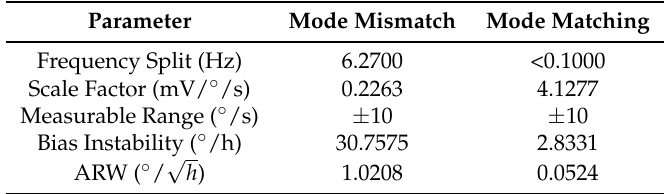
Table 3. Performance test results (room temperature, open-loop detection).